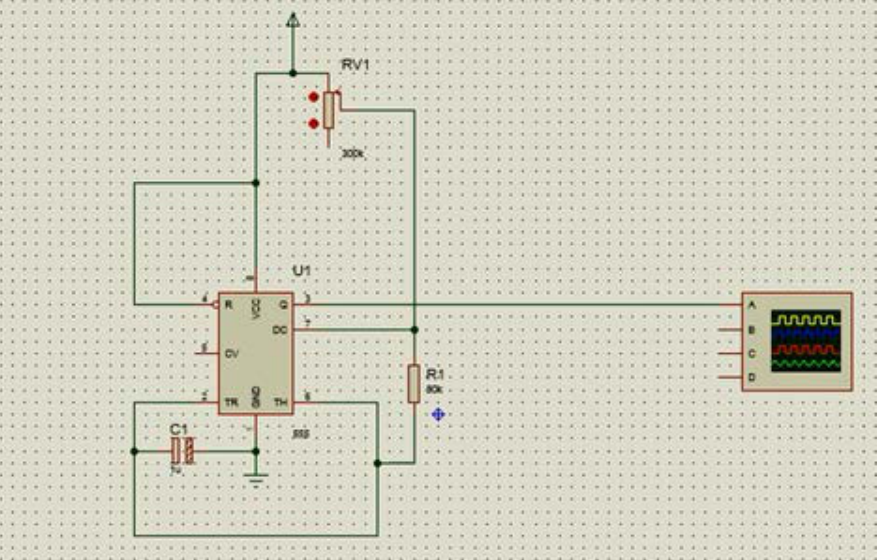
Figure 3. Circuit diagram of voltage to frequency converter.